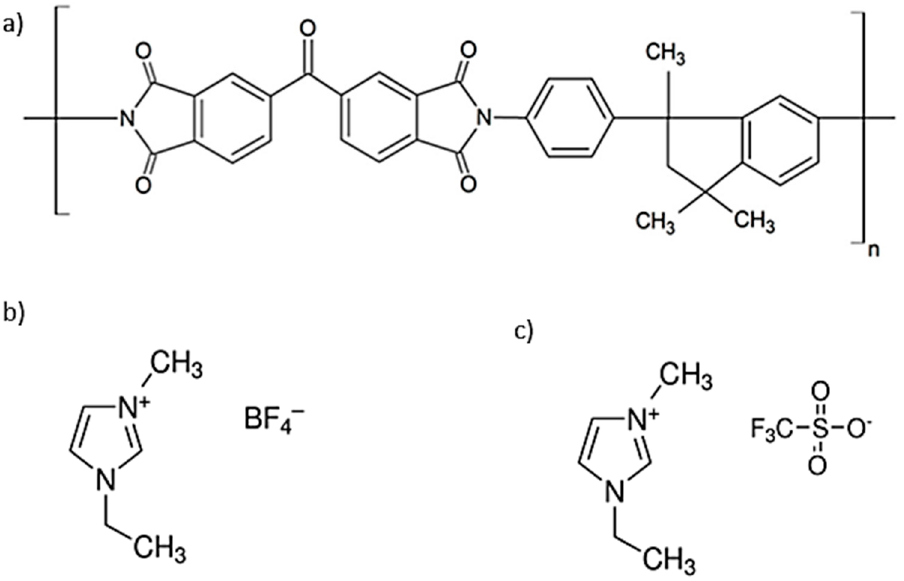
Figure 1. Schematic representation of the chemical structures of the ( a ) polymer Matrimid ® 5218, and the ILs ( b ) [EMIM][BF 4 ] and ( c ) [EMIM][OTf].